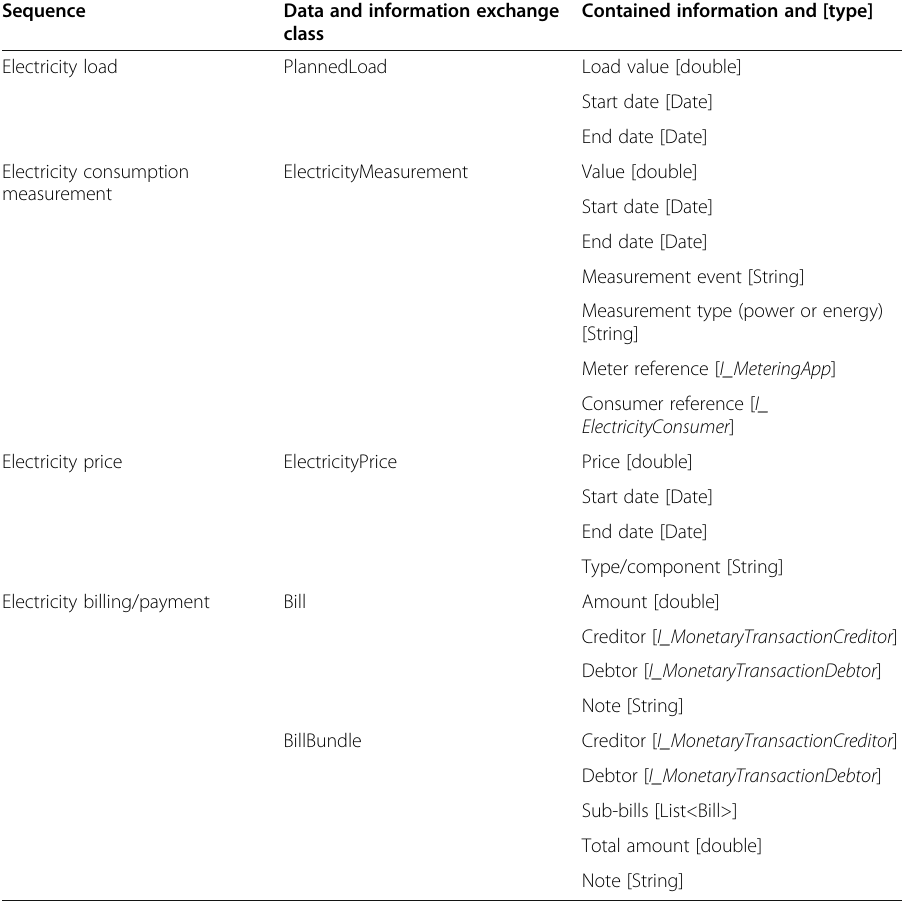
Table 4 A list of data and information exchange classes, the information they contain, and the sequences where they are prominently used